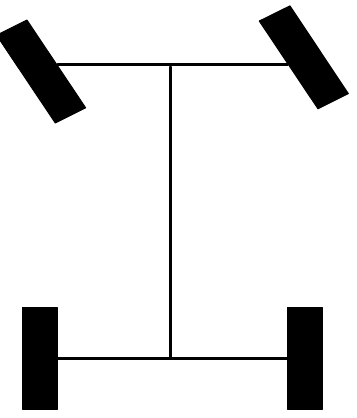
Figure 3. Movement principle of four-wheel wheel mechanism.